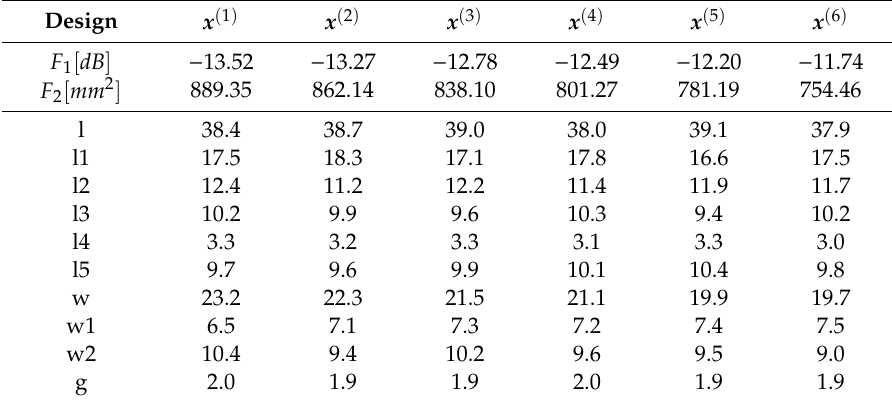
Figure 12. Simulated (—) and predicted ( ○ ) reflection responses for the designs of the PF in Figure 11 (from top left to bottom right): ( a ) x (1) , ( b ) x (2) , ( c ) x (3) , ( d ) x (4) , ( e ) x (5) , ( f ) x (6) . Table 4. Planar Multiband Antenna: Selected Pareto-Optimal Designs.